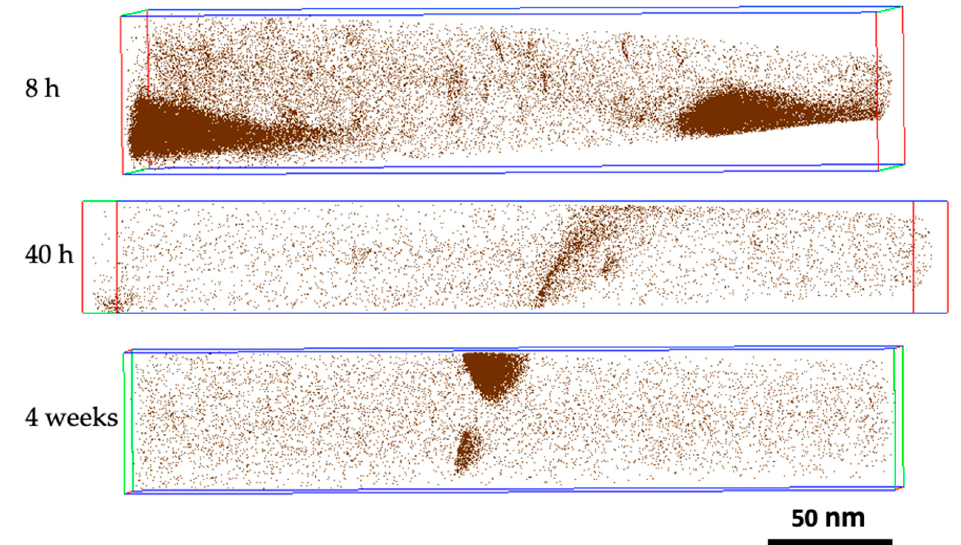
Figure 8. Atom maps showing all C atoms in samples aged at 600 °C for 8 h, 40 h, and four weeks. The analysis of the 8 h sample contains two large Fe 3 C and several small elongated carbides enriched in Mo and V. The carbides seen in the sample aged for four weeks are MC, rich in Mo and V.